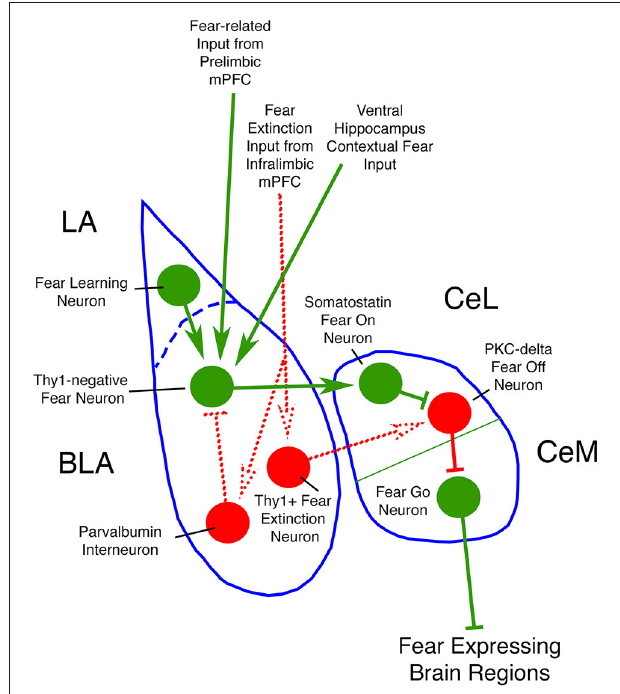
FIGURE 8 | Circuit diagram of neuron types of amygdala of interest to the present study. Neurons and inputs shown in green promote fear, while those shown in red reduce fear. Dotted lines represent connections that are less firmly established in the literature than are the connections shown by solid